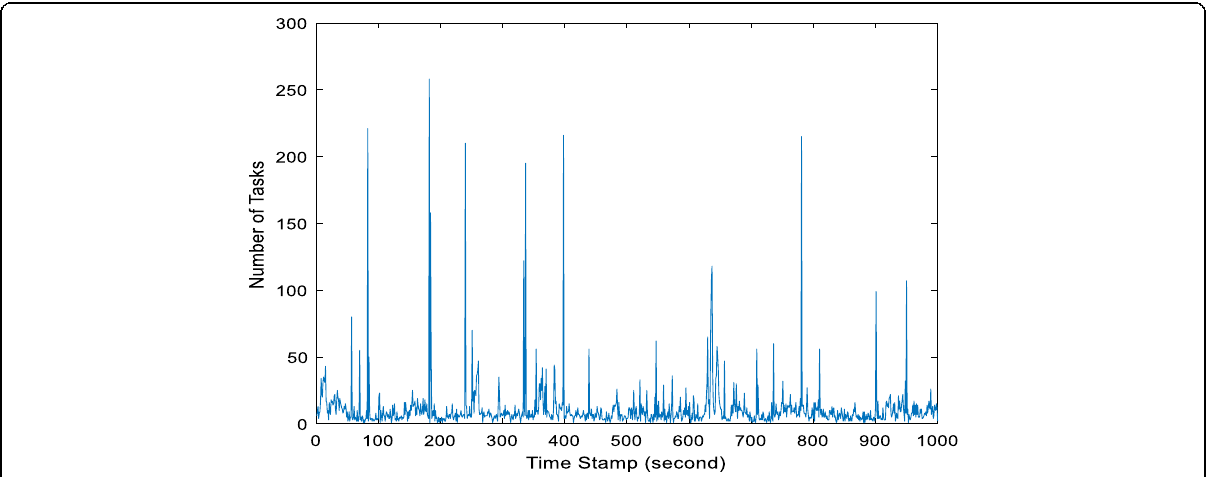
Fig. 9 The number of tasks to be scheduled during a 1000-s